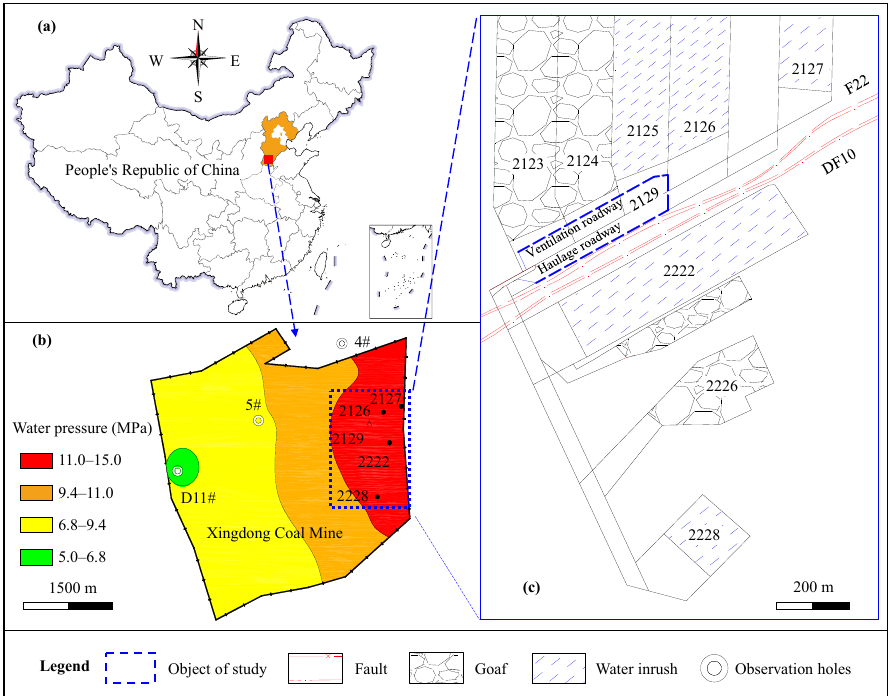
Figure 1. Location of the study area and layout of floor water inrush faces: ( a ) Location of the Xingdong coal mine; ( b ) Water pressure of Ordovician limestone aquifer; ( c ) Object of study and layout of floor water inrush faces.